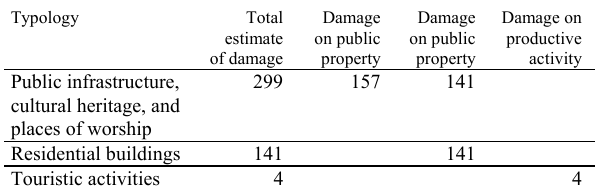
Table 1: the estimates are in millions of euro. Some typologies are not inserted in the table (industrial, handmade, agricultural activities)